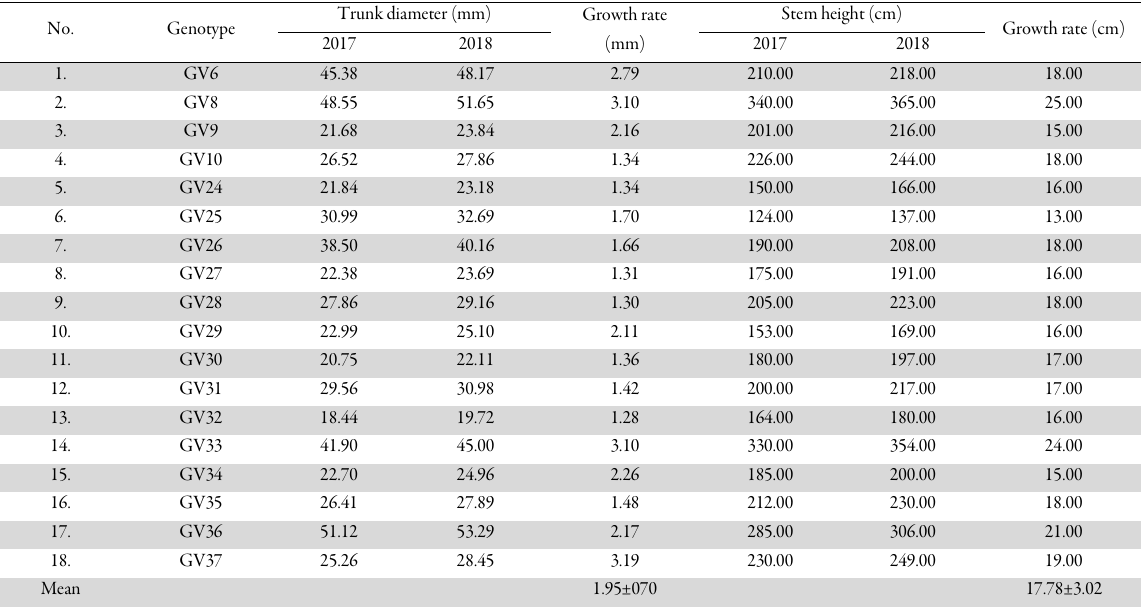
Table 2. Growth vigor of genotypes in Gura Vaii population, expressed in terms of growth rate in thickness and height